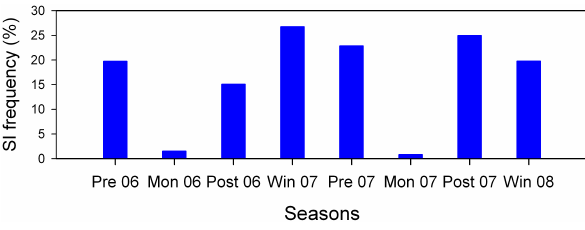
Fig. 5. Seasonal variation of SI frequency at NCO-P during the period March 2006–February